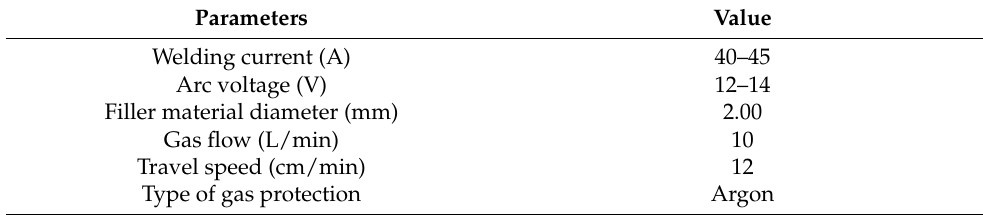
Table 4. The welding parameters used in the TIG welding